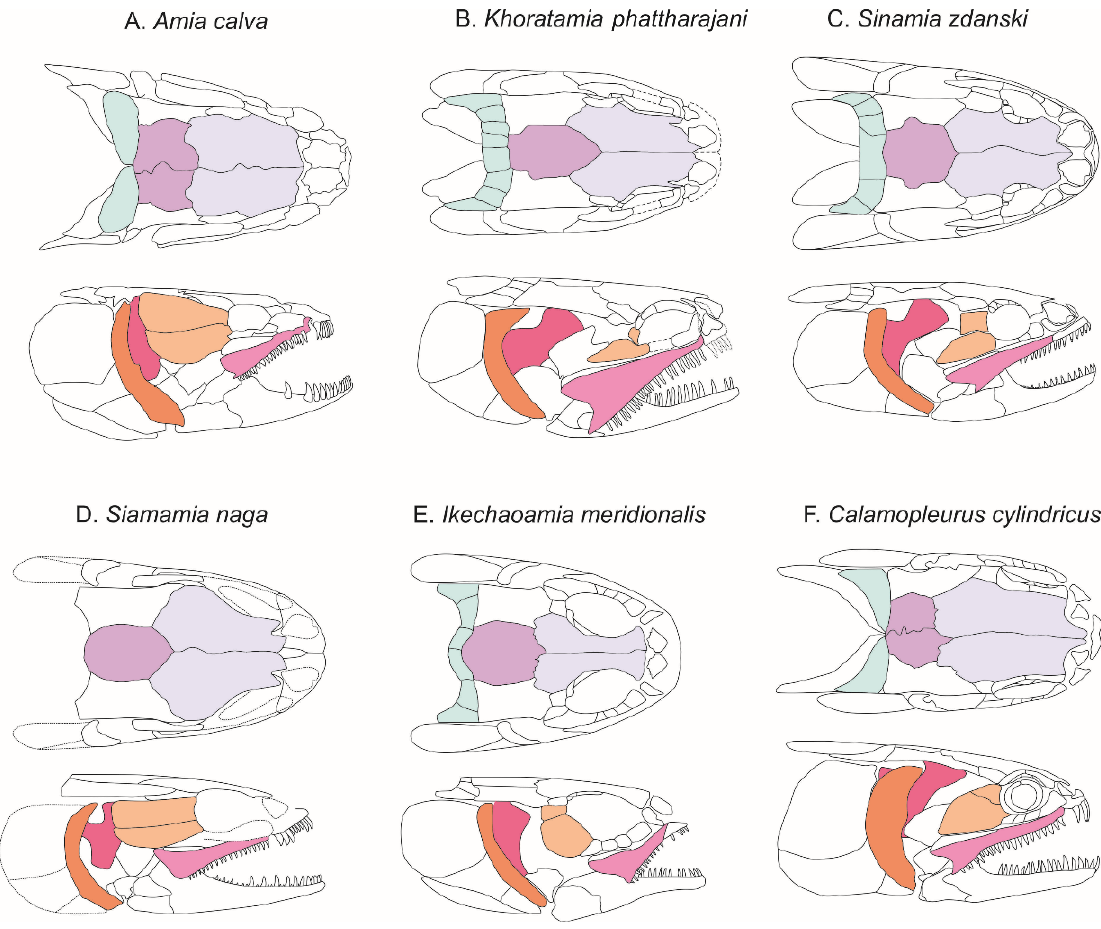
Figure 8. Comparison of reconstructed skulls of various amiids in dorsal and lateral views. The colored bones are those discussed in the text.